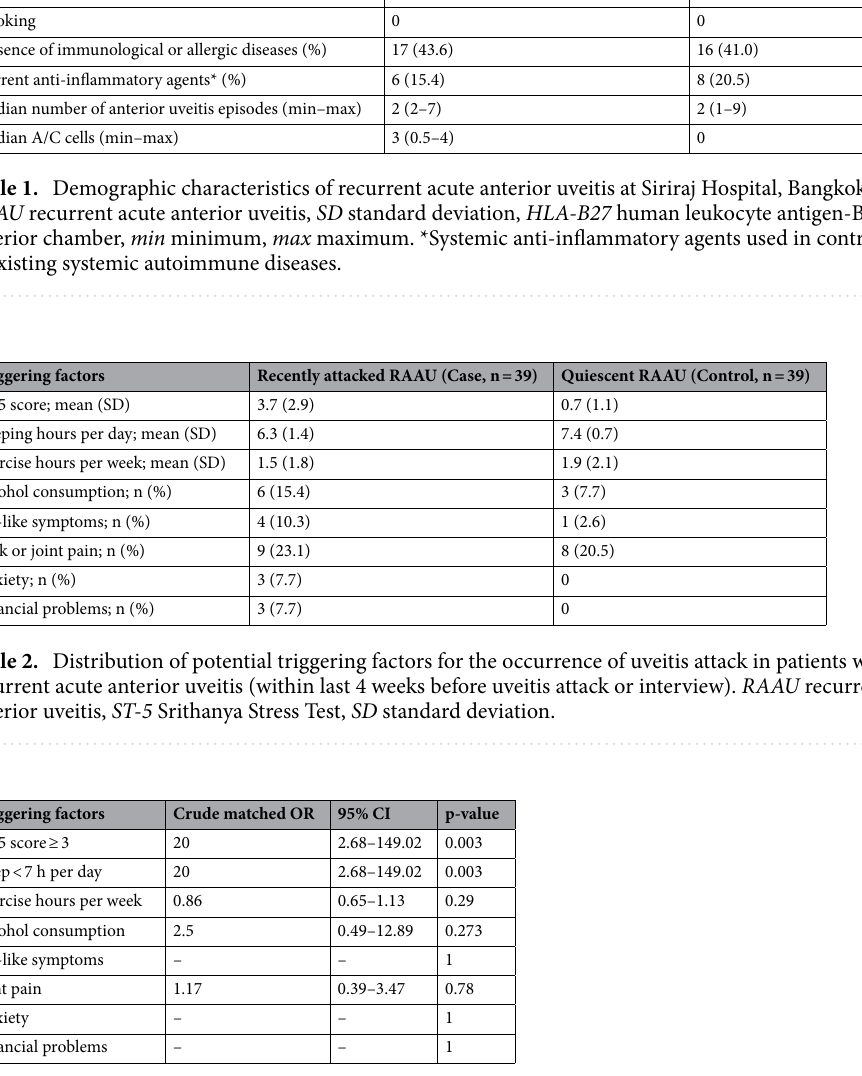
Table 3. Univariate conditional logistic regression analyses of triggering factors for the occurrence of uveitis attack in patient with recurrent acute anterior uveitis. OR odds ratio, CI confidence interval, ST-5 Srithanya Stress Test.